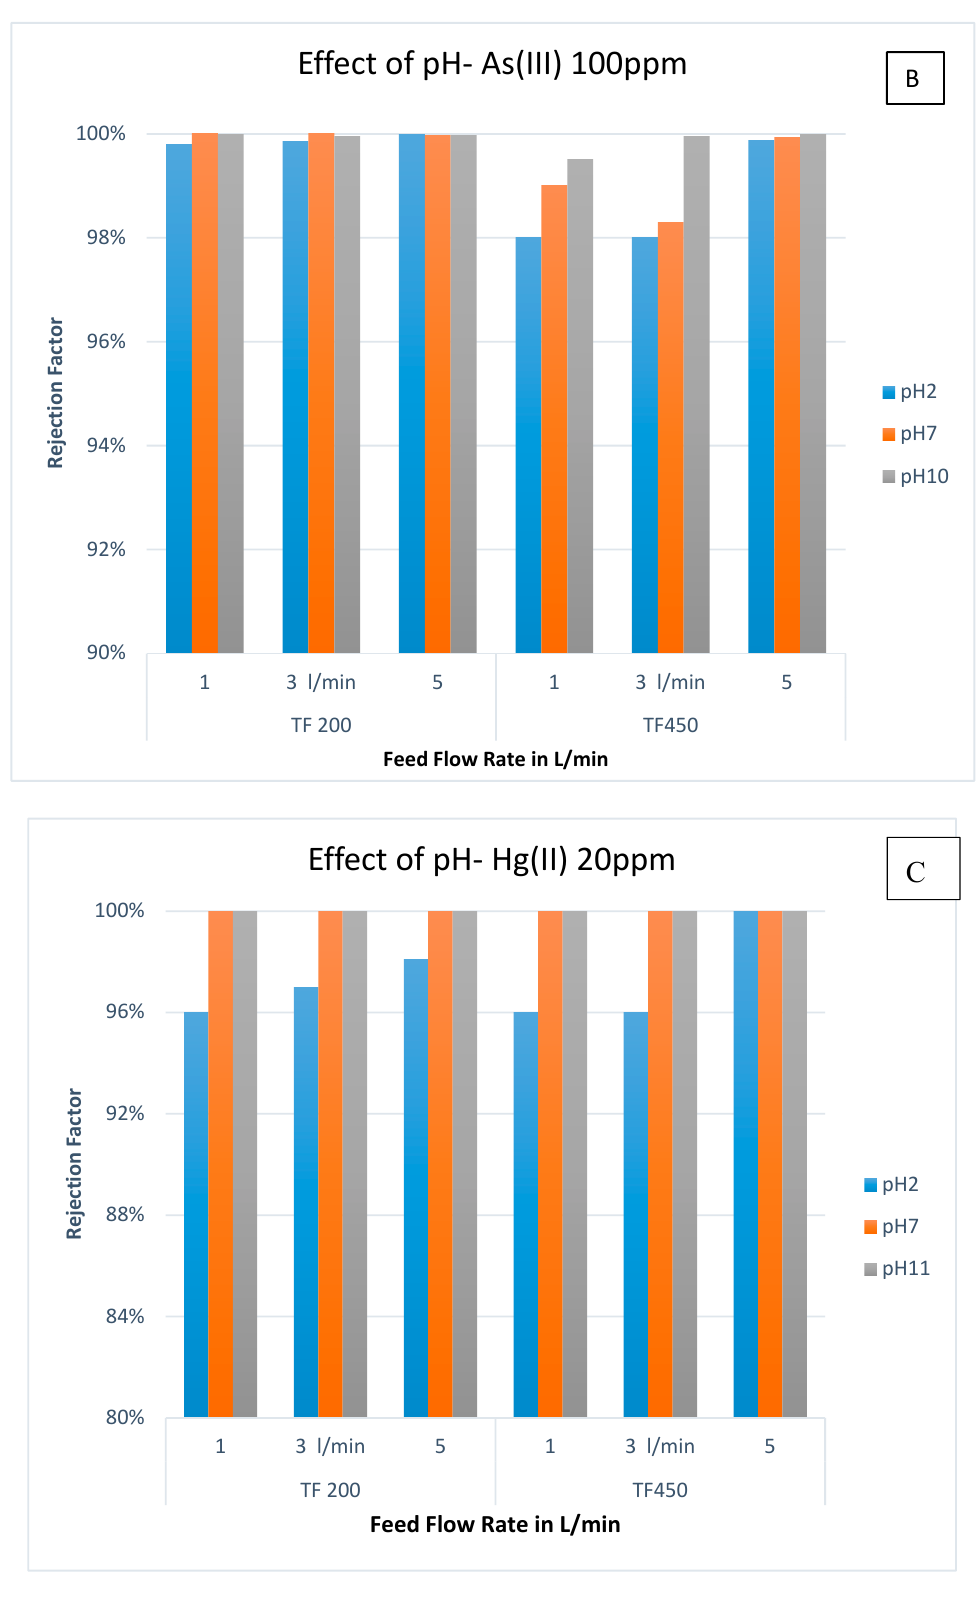
Figure 9. Effect of pH on the rejection factor using TF200/TF450 membranes for ( a ) Pb(II), ( b ) As(III) Figure 9. E ff ect of pH on the rejection factor using TF200 / TF450 membranes for ( A ) Pb(II), ( B ) As(III) and ( c ) Hg(II) (feed temperature = 50 °C, flow rate = 3 L/min). and ( C ) Hg(II) (feed temperature = 50 ◦ C, flow rate = 3 L /